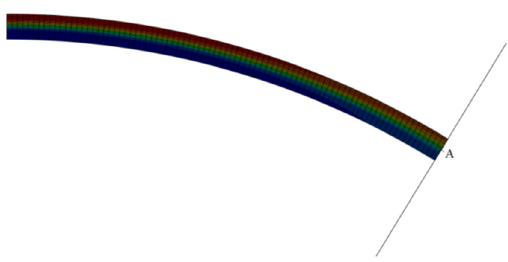
Figure 10. Finite element modelling of the pure bending of the metal sheet sample.